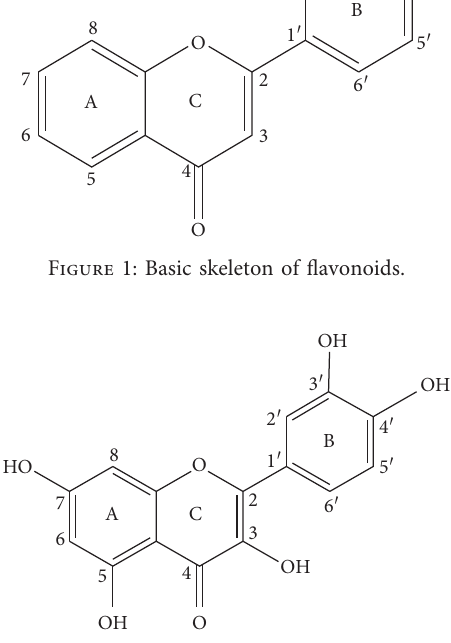
Figure 2: Quercetin